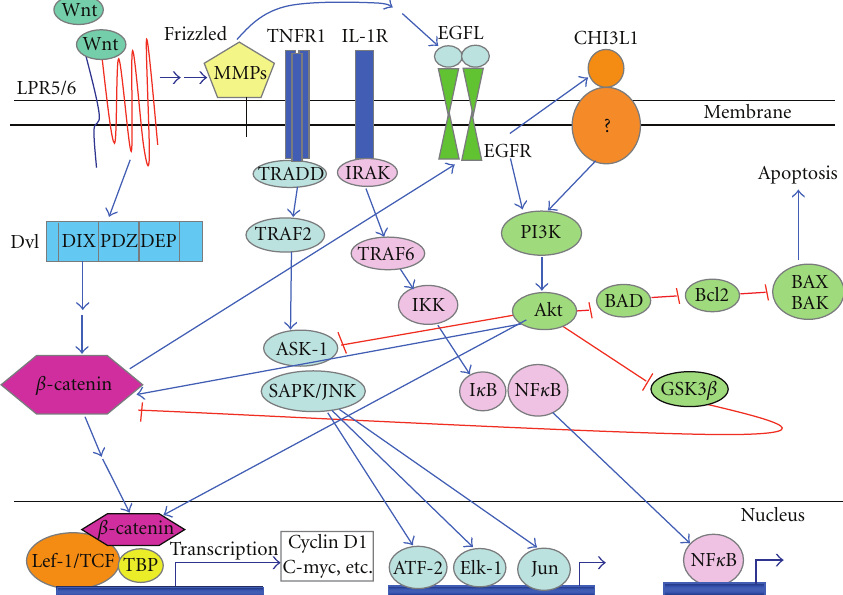
Figure 3: Wntsignalingplays central role in embryogenesis and humandiseasesincluding cancers. Wnt ligands to 7-transmembrane domain receptor Frizzled, which transactivates EGFR signaling by MMP-mediated release of soluble EGFR ligands. Activated EGFR transactivates β - catenin via receptor tyrosine kinase-PI3K/Akt pathway, and β -catenin also forms heterodimer with EGFR and further activate EGF pathway. Direct activation of EGFR utilizing EGF-family ligands induces CHI3L1 expression, which binds to a putative receptor on cell membrane and leads to PI3K-mediated phosphorylation of Akt followed by β -catenin transactivation. As shown in this figure, Wnt and EGFR pathwayshave been reported to closely interact in tumorigenesis by crosstalking and coactivating tumor progression. The activation of ASK1, following of TNF/TNFR1 and/or IL-1/IL-1R ligation, activates SAPK/JNK and MAPKp38 followed by increased production of MMPs and cytokines. NF- κ B signal is also activated by TNF and IL-1, which is highly involved in the development of chronic colitis as well as colitis-associated cancer formation. The abbreviations used in this figure are: ASK-1, apoptosis signal-regulating kinase 1; ATF-2, activating transcription factor 2; BAD, Bcl2-antagonist of cell death; Bcl2, B-cell lymphoma 2; CHI3L1, chitinase 3-like-1; EGF, epidermal growth factor; Elk-1, Ets like gene 1; GSK3 β , glycogen synthesis kinasse 3 beta, Lef-1/TCF, lymphoid enhancer-binding factor-1/Tcell factor; IKK, I κ B kinase; IRAK, IL-1 receptor associated factor; LPR5/6, lipoprotein-related receptor 5 and 6; PI3K, phosphoinositide 3-kinase; SAPK/JNK, stress-activated protein kinase/c-Jun NH2-terminal kinase; TBP, TATA-binding protein; TNFR1; Tumor necrosis factor receptor 1; TRADD, TNF receptor 1-associated death domain; TRAF, TNF receptor associated